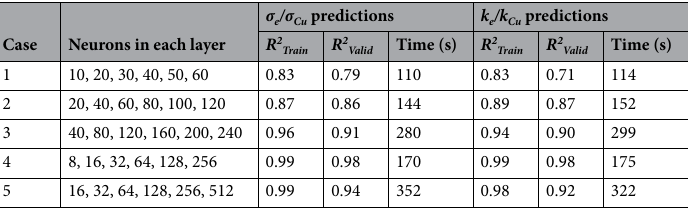
Table 1. CNN model R 2 and training time obtained with various hidden layer